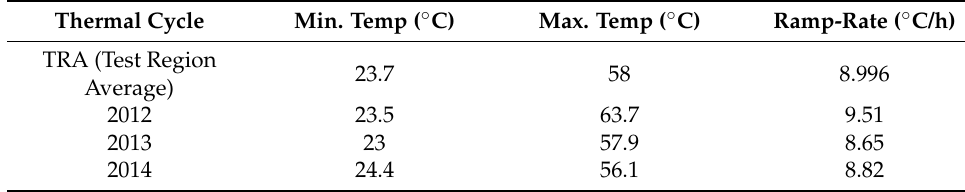
Table 4. Thermal load and boundary conditions from field thermal